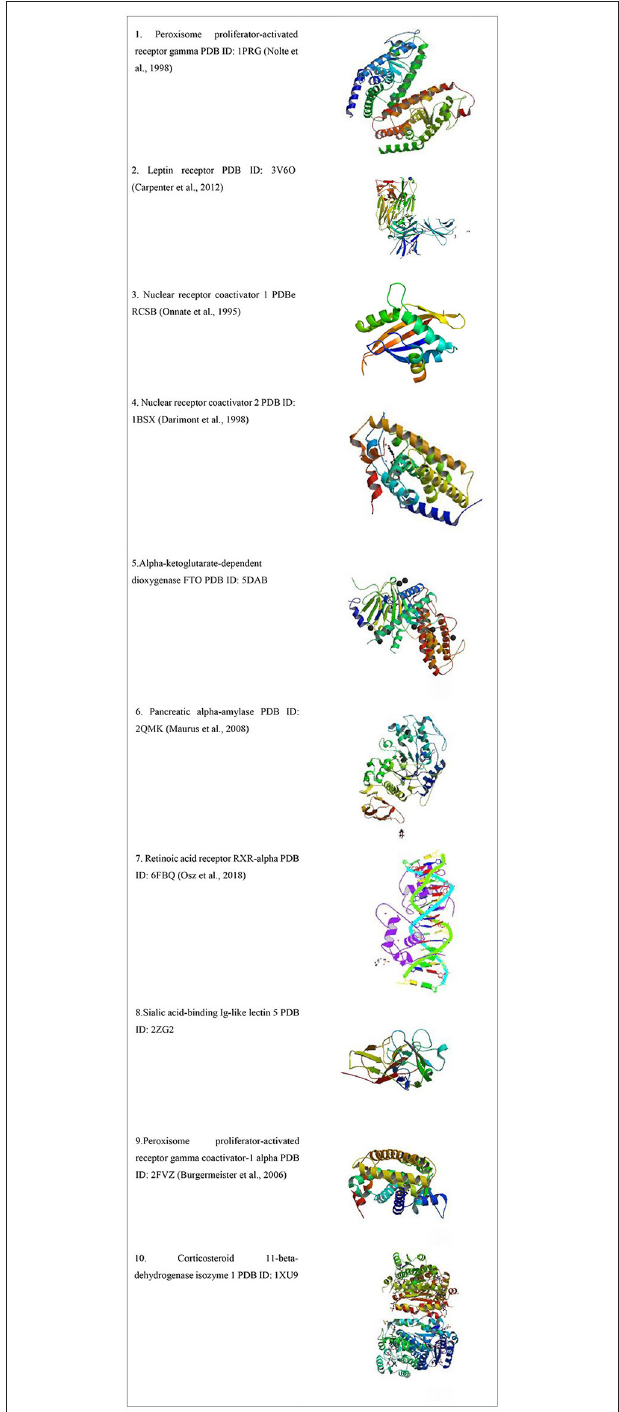
FIGURE 2 | 3D structures of obesity receptors from Protein Data Bank ( 27–33).